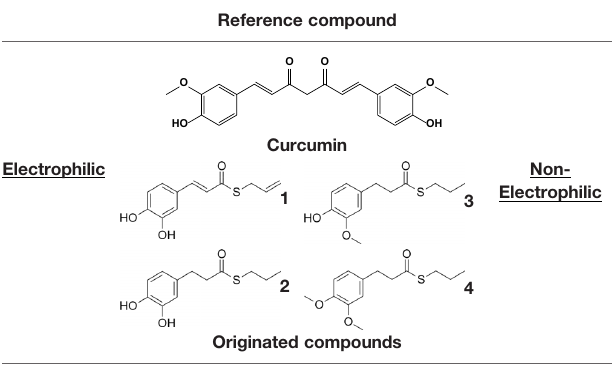
TABLE 1 | Design strategy of electrophilic and non-electrophilic